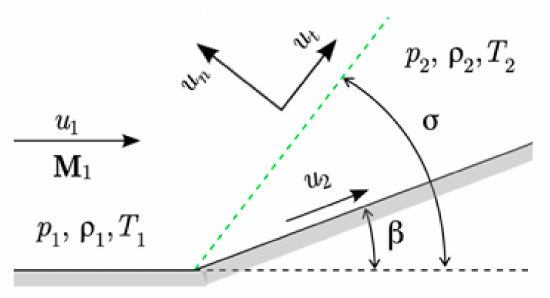
Figure 2. Oblique shock